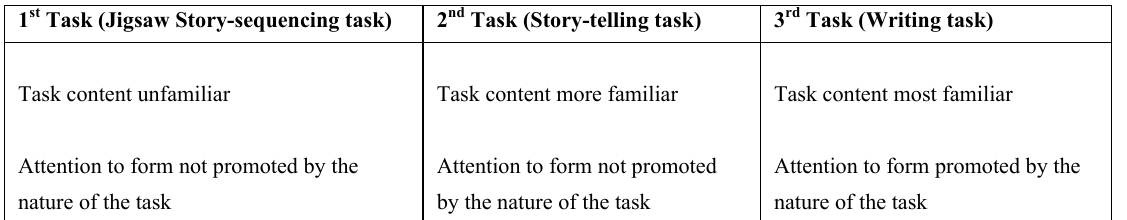
Characteristics of the